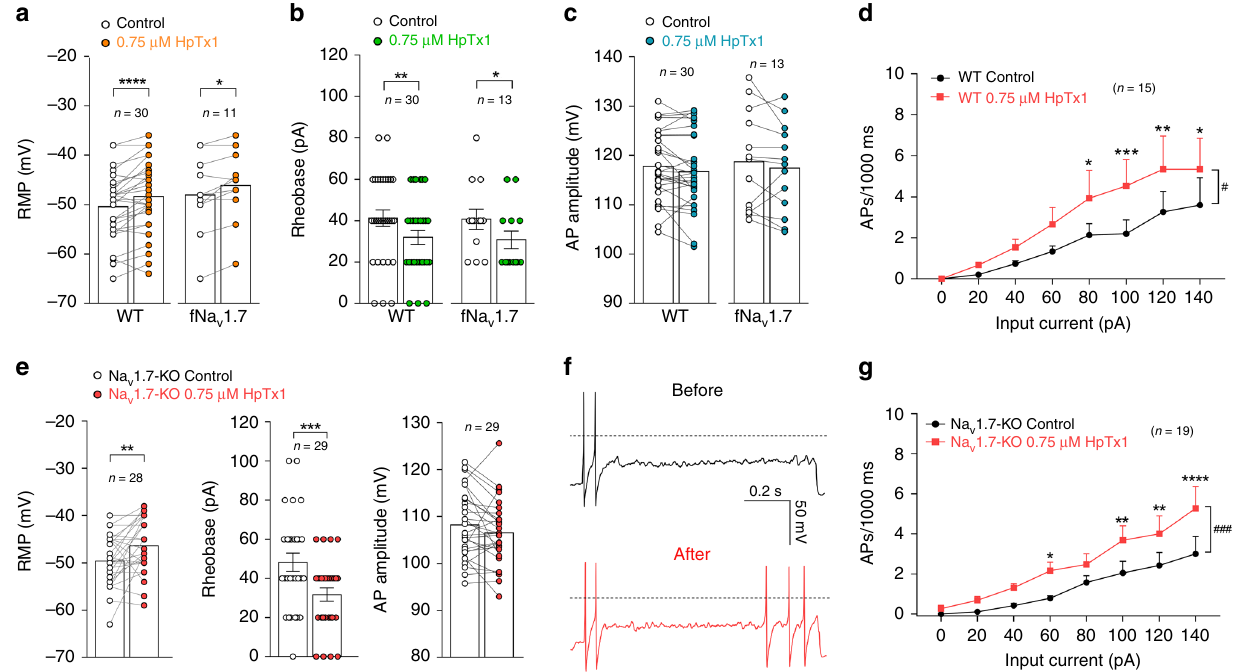
Fig. 2 HpTx1 activates some small DRG neurons in WT and Na v 1.7-KO mice. a – d Current-clamp recording shows that HpTx1 enhances the excitability of small (<30 μ m) DRG neurons from WT and fNa v 1.7 mice. Bars show signi fi cant changes for RMP ( a , two-way repeated measures ANOVA followed by Bonferroni ’ s multiple comparisons test, treatment × genotype: F (1,39) = 0.02197, P = 0.8829; treatment: F (1,39) = 22.12, P < 0.0001; genotype: F (1,39) = 0.9114, P = 0.3456) and rheobase ( b , two-way repeated measures ANOVA followed by Bonferroni ’ s multiple comparisons test, treatment × genotype: F = 0.01839, P = 0.8928; treatment: F = 15.47, P = 0.0003; genotype: F = 0.02329, P = 0.8795), but no effect on AP amplitude ( c ) in the (1,41) (1,41) (1,41) presence of 0.75 μ M HpTx1. d Statistics plots show signi fi cant increases in AP spike number in the presence of 0.75 μ M HpTx1 ( n = 15, two-way